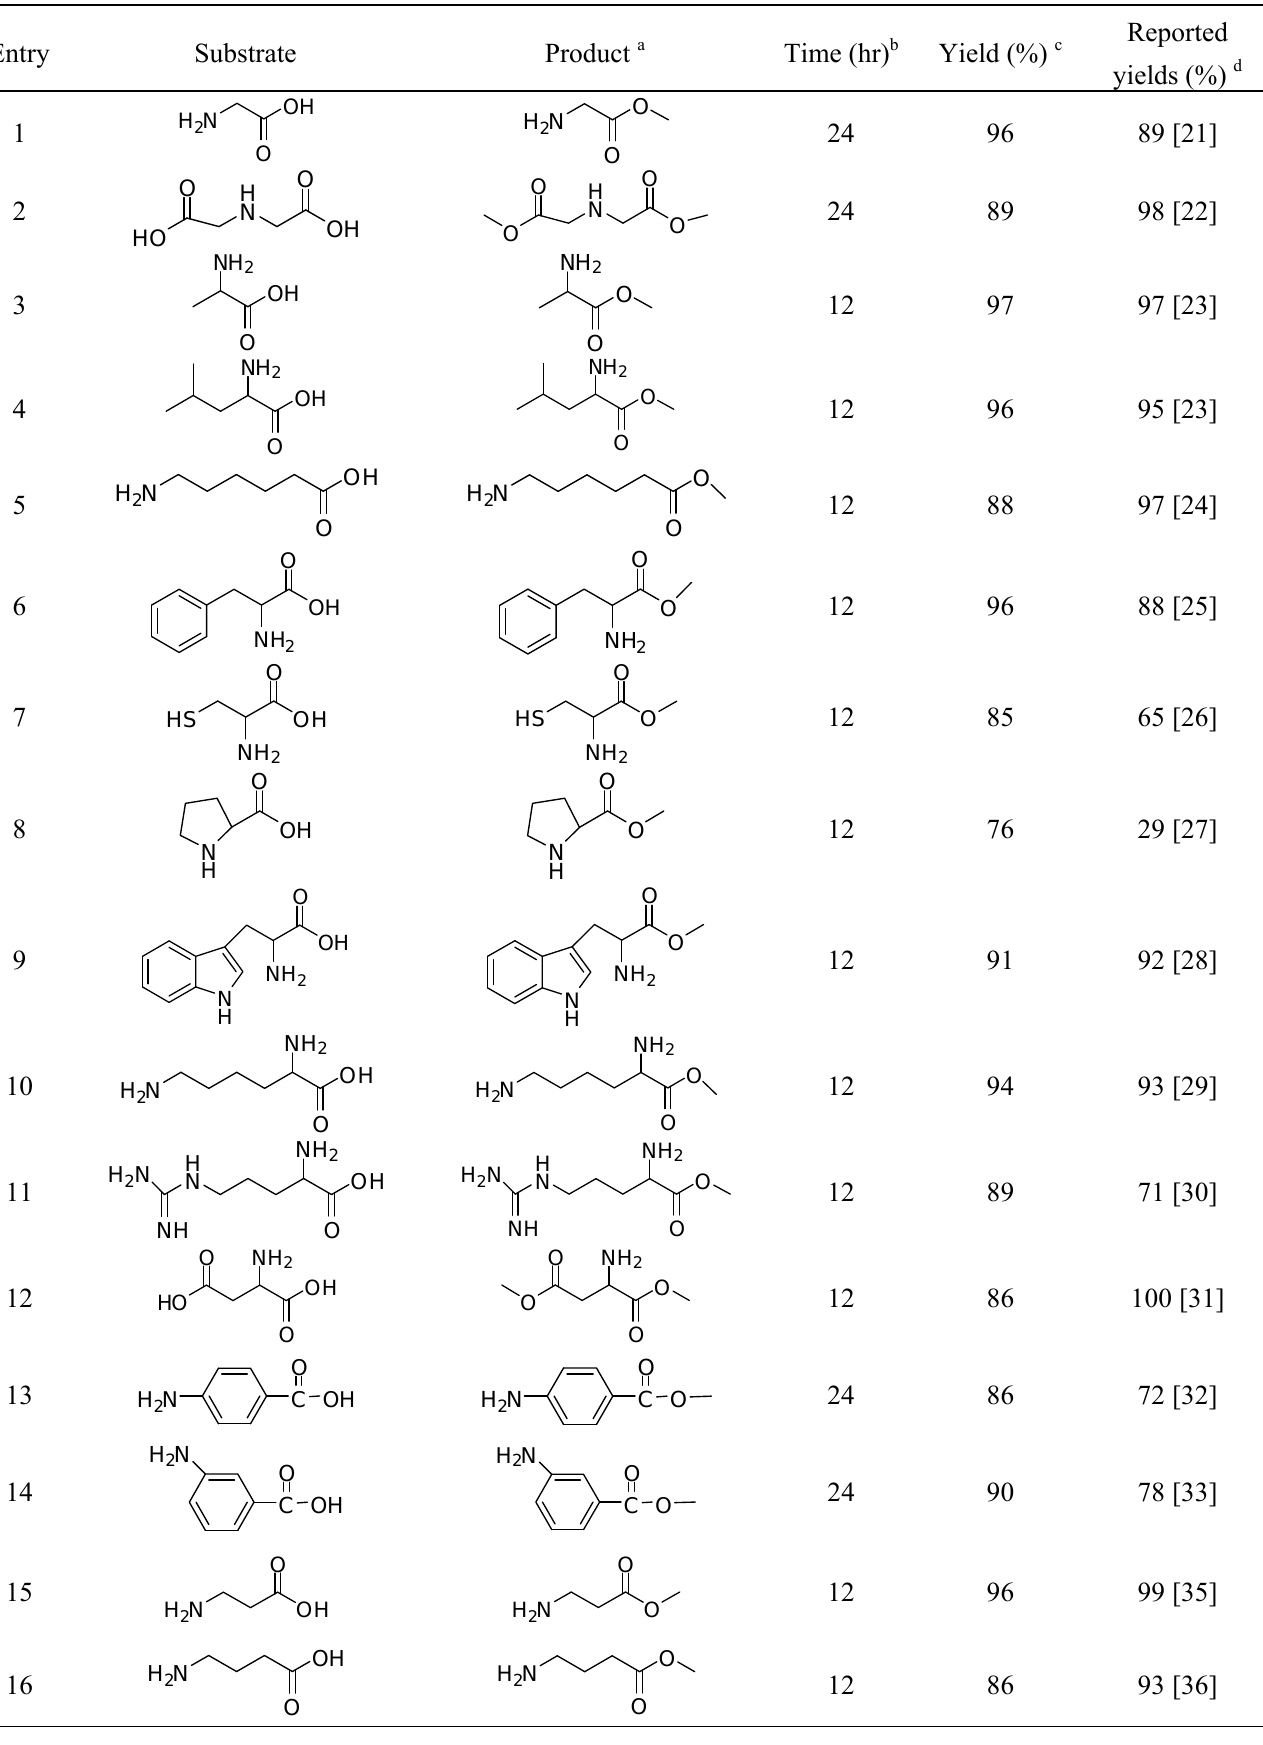
Reported yields (%)